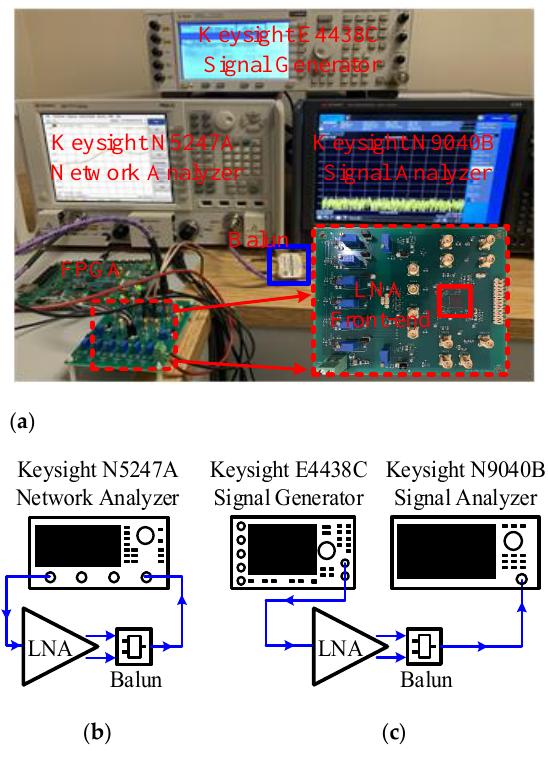
Figure 16. ( a ) Measurements setup; ( b ) S 11 and frequency response measurement; and ( c ) noise density and THD measurement.